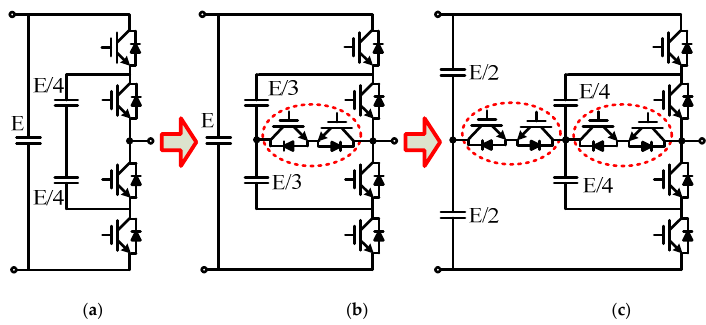
Figure 5. Derivation process of 5L SM converter. ( a ) 3L FC cell [7], ( b ) 4L NNPC converter [22], ( c ) 5L SM converter [28].